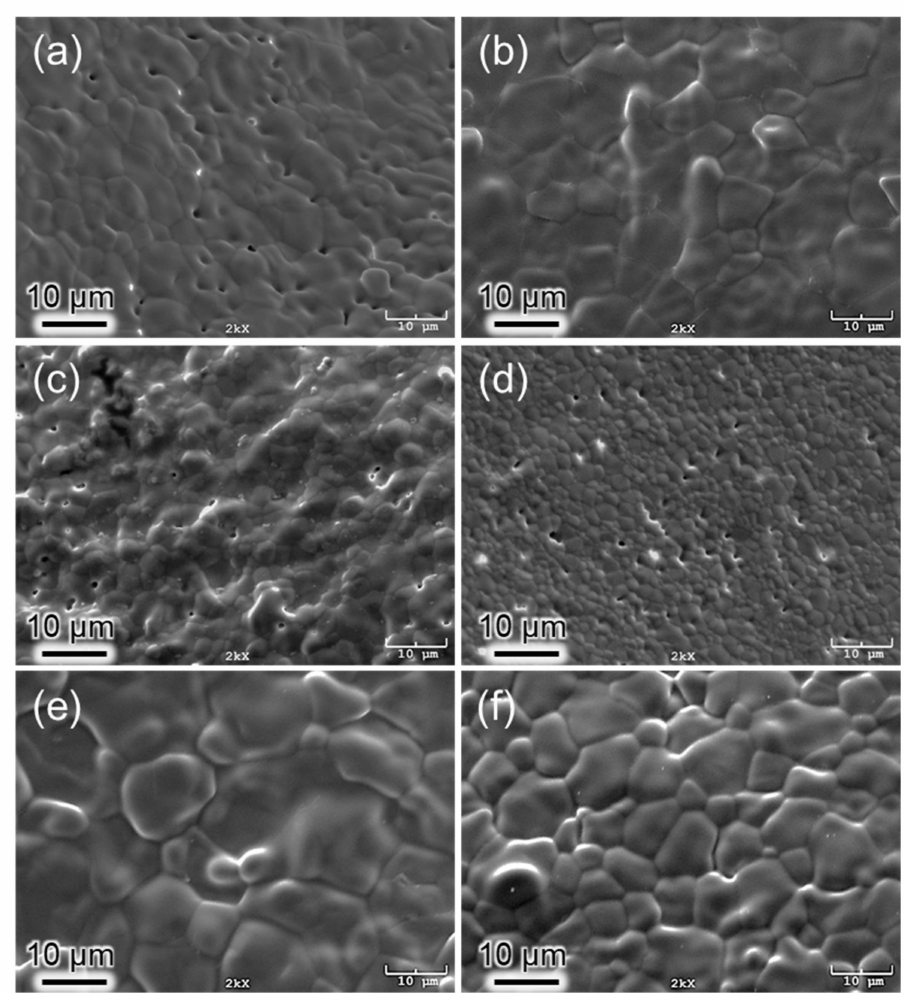
Figure 4. SEM images of AgHAs and pure HA heat-treated at 1100 ◦ C: ( a ) HA, ( b ) E2, ( c ) C2, ( d ) C5, ( e ) P2, and ( f ) P5. (Scale bar = 10 µ